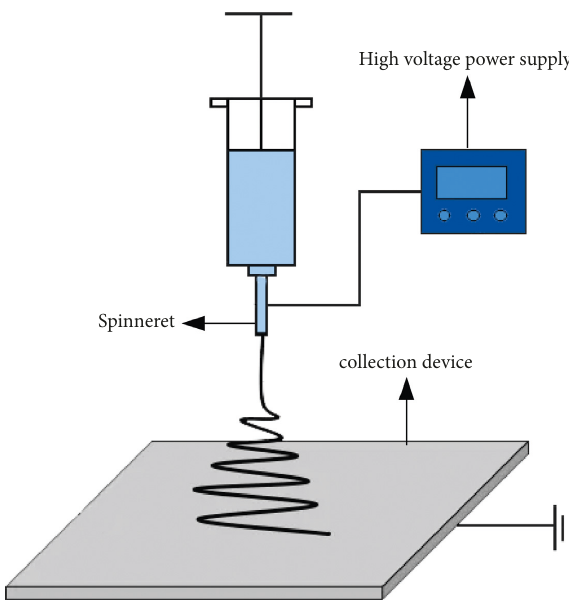
Figure 4: Schematic diagram of